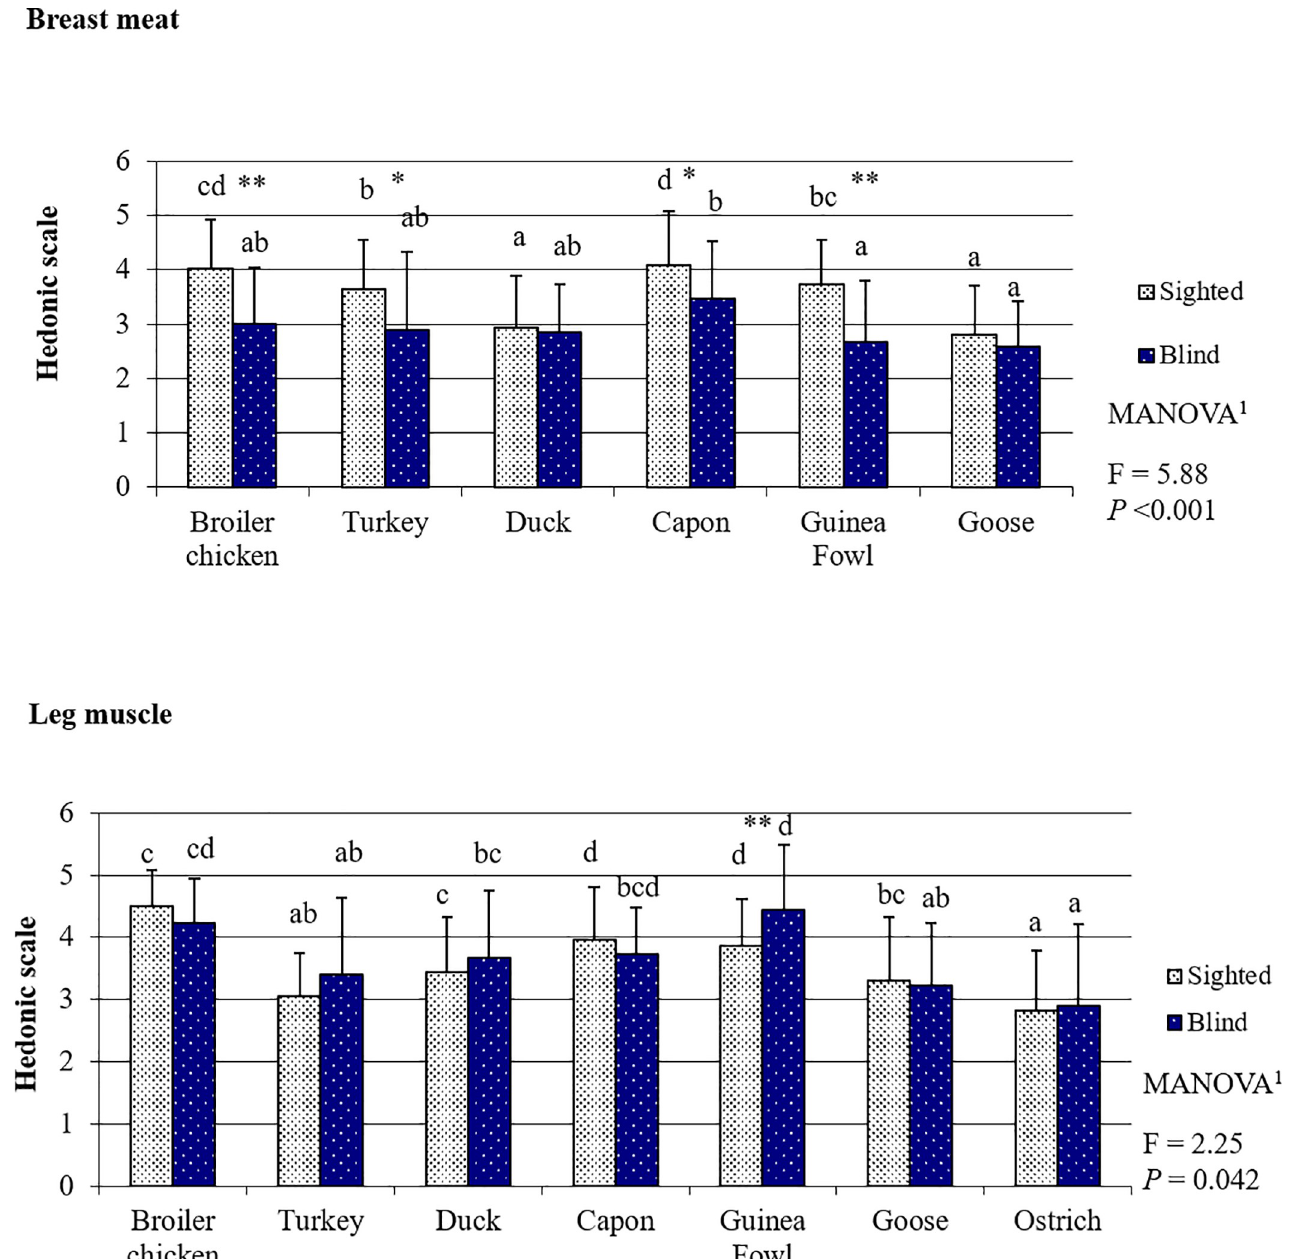
Fig 5. Poultry meat juiciness based on the evaluation by the sighted and blind panelists. https://doi.org/10.1371/journal.pone.0210722.g005 Poultry meat overall liking evaluated by the sighted and blind panelists In BM assessment by the sighted panelists, the best in terms of overall liking (Fig 6, S6 Table) turned out to be meat from capon (all BMs P < 0.05), followed by broiler chicken and Guinea fowl (both P > 0.05). The worst scores were given by these panelists to BM from turkey, goose, and duck (all three P > 0.05). The blind consumers also assessed capon BM as the best in terms of overall liking. For LM, the highest scores for overall liking were given by the sighted